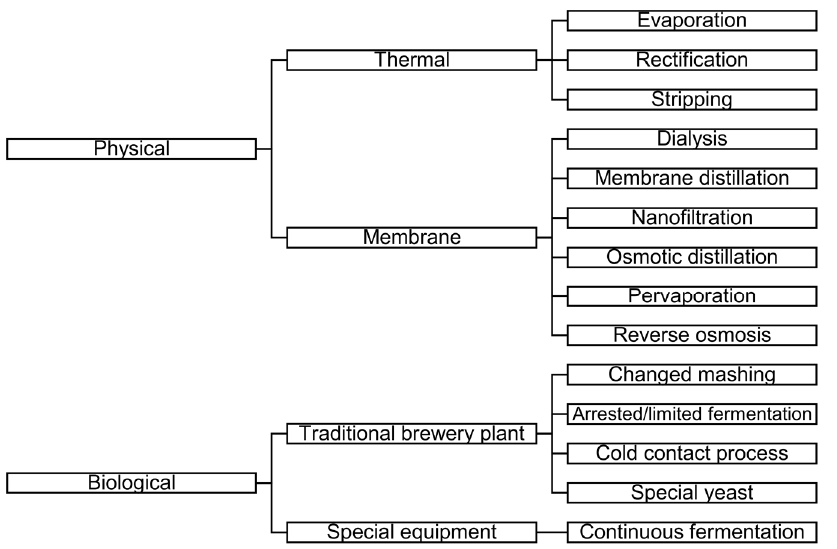
Figure 1. Schemes of low-alcohol beer (LAB) and alcohol-free beer (AFB) production methods (based on [3,5–8]).